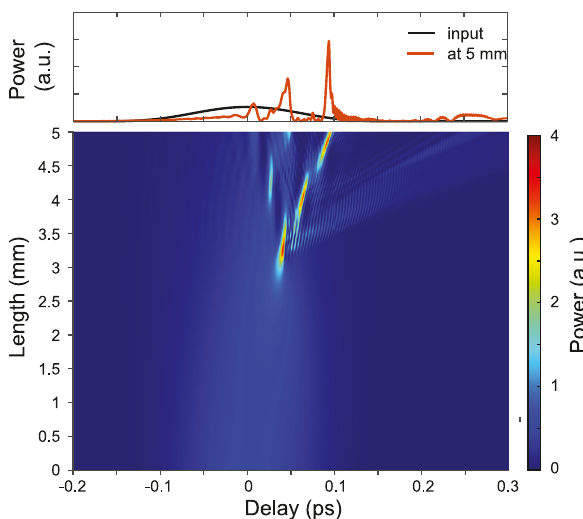
Figure 4: Simulated temporal envelope on top (black – input, red – output), and temporal pump pulse evolution in the bottom, corresponding to the same conditions as in Figure